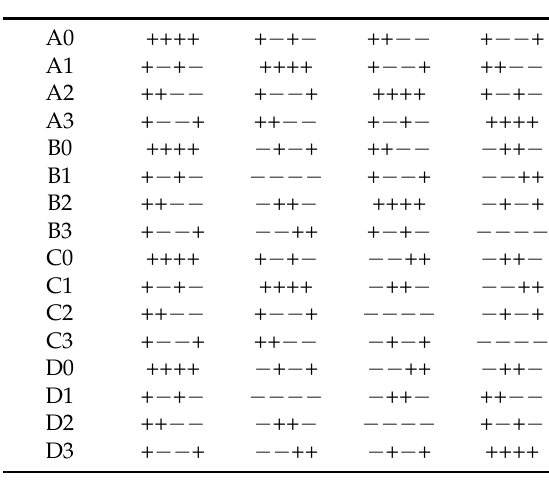
Table 1. {4, 4, 16} Complete Complementary Code.